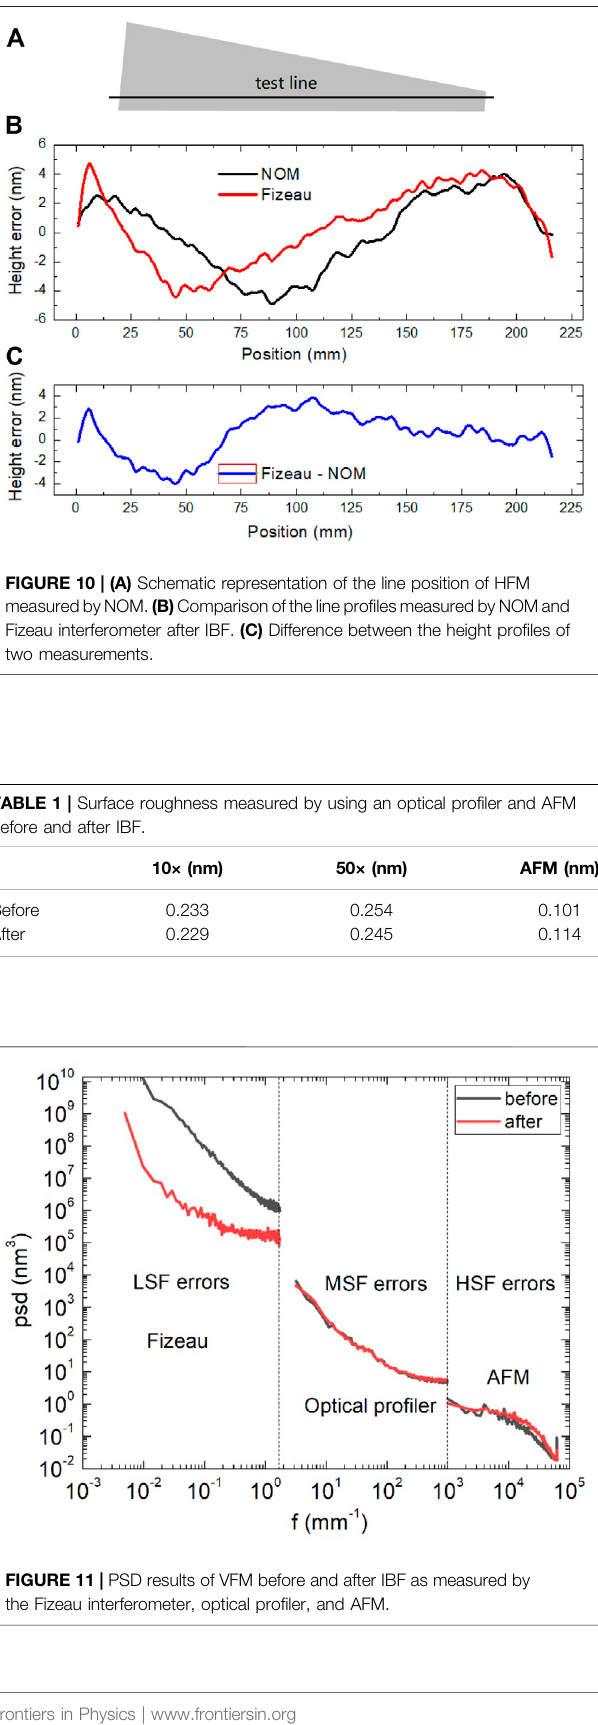
Frontiers in Physics |